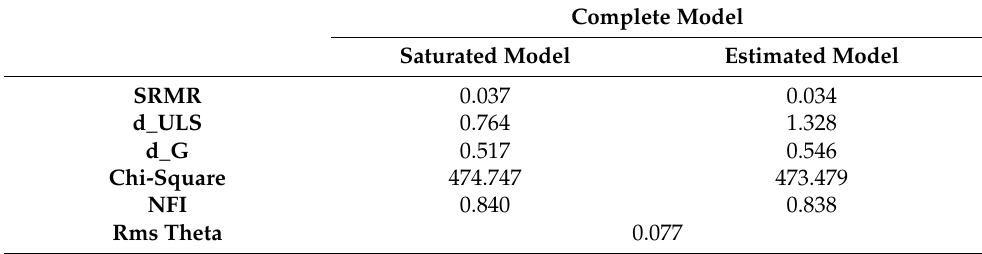
Table 8. Model fit